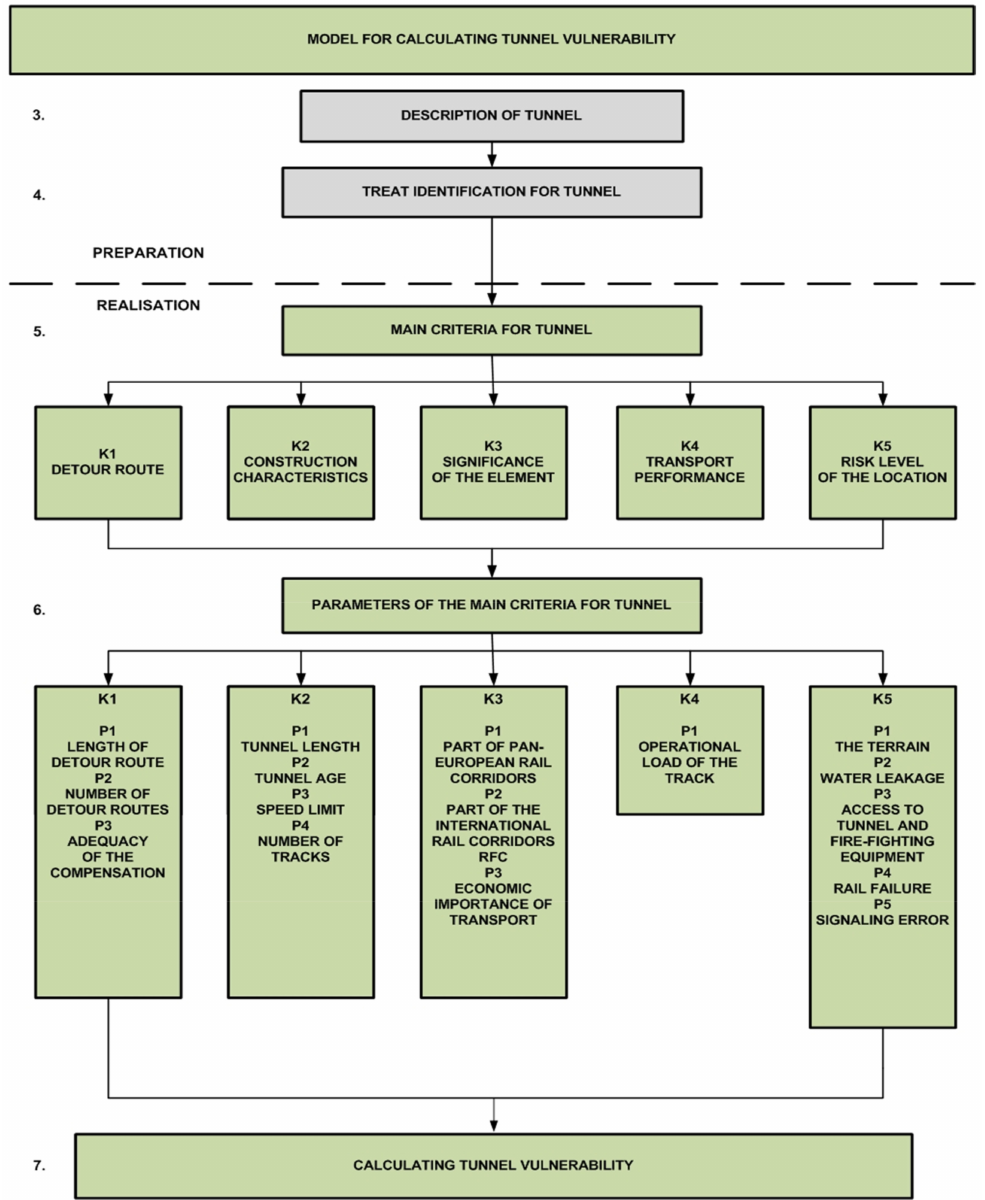
Figure 5. Model for calculating the vulnerability of the railway